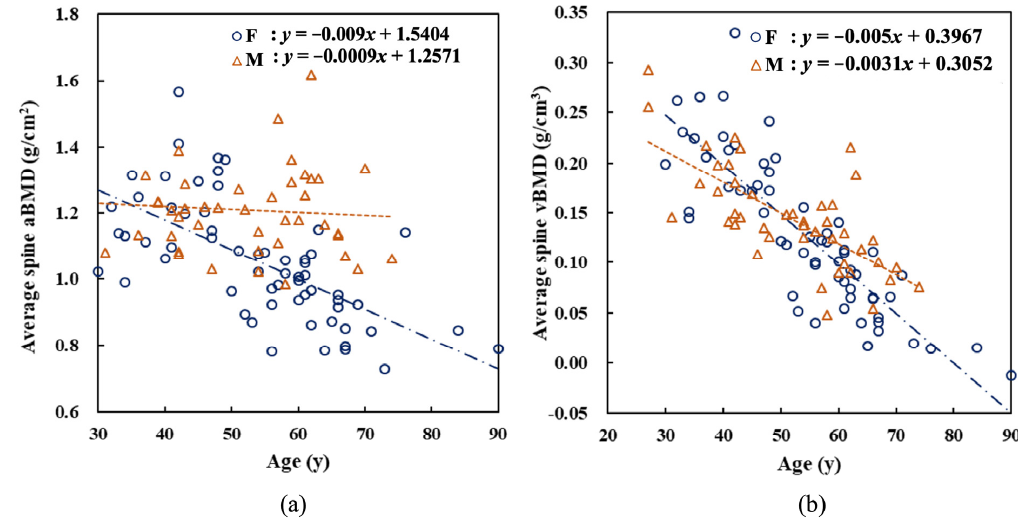
Figure 7. Linear fitting of ( a ) aBMD and ( b ) vBMD averaged over the four lumbar vertebrae as a function of age for men (M) and women (F). aBMD and vBMD show a downward trend with increase in age.